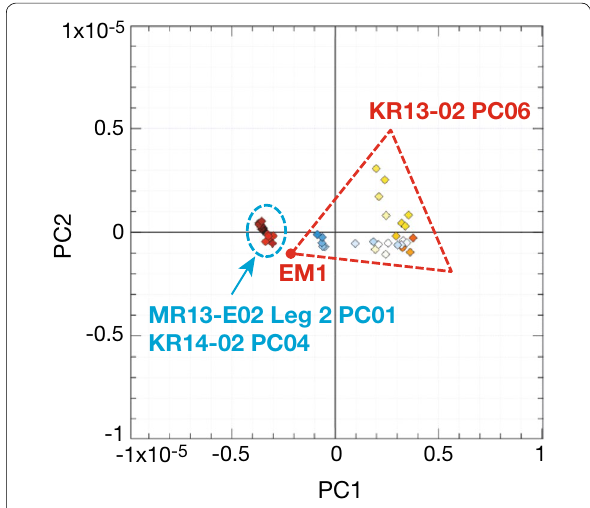
Fig. 7 FORC-PCA results for the three cores from the western North Pacific. PCs of nine FORC diagrams for core MR13-E02 Leg 2 PC01 and seven FORC diagrams for core KR14-02 PC04 cluster (dashed oval) on the PC1-PC2 plane near EM1 (red circle) of the three-EM system (red triangular dashed lines) defined in the FORC-PCA solution for core KR13-02 PC06 alone shown in Fig. 4